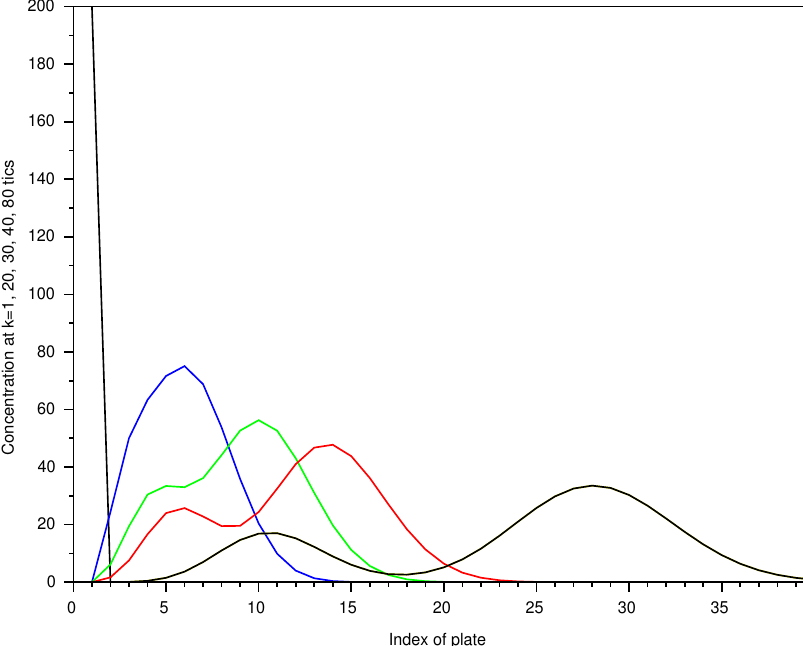
Figure 6. Batch mode: spatial concentration in a column of 40 plates, with a retention ratio (cid:101) m = 0.1, an unit plate volume V c = 1, an amount Q inj = 2.5, from a 10 tick-injection, with two solutes of K d 1 = 0.2 and K d 2 = 0.8. As the elution proceeds, the two solutes spread out according to a diffusion process and are separated. The list of instants is color coded: 1 (black), 20 (blue), 30 (green), 40 (red), 80 ticks (black).